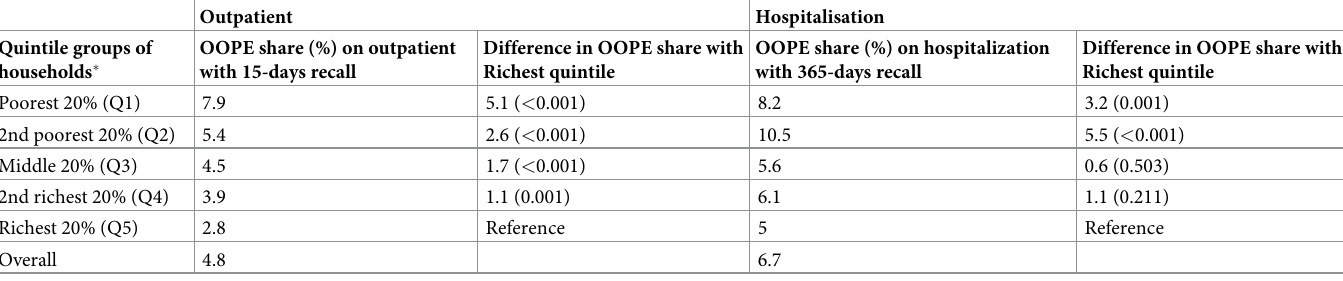
Table 5. Average share of household consumption expenditure incurred on treatment of childhood infections (age 0–5 years) in outpatient and hospitalisation by different quintiles. Outpatient Hospitalisation Quintile groups of households